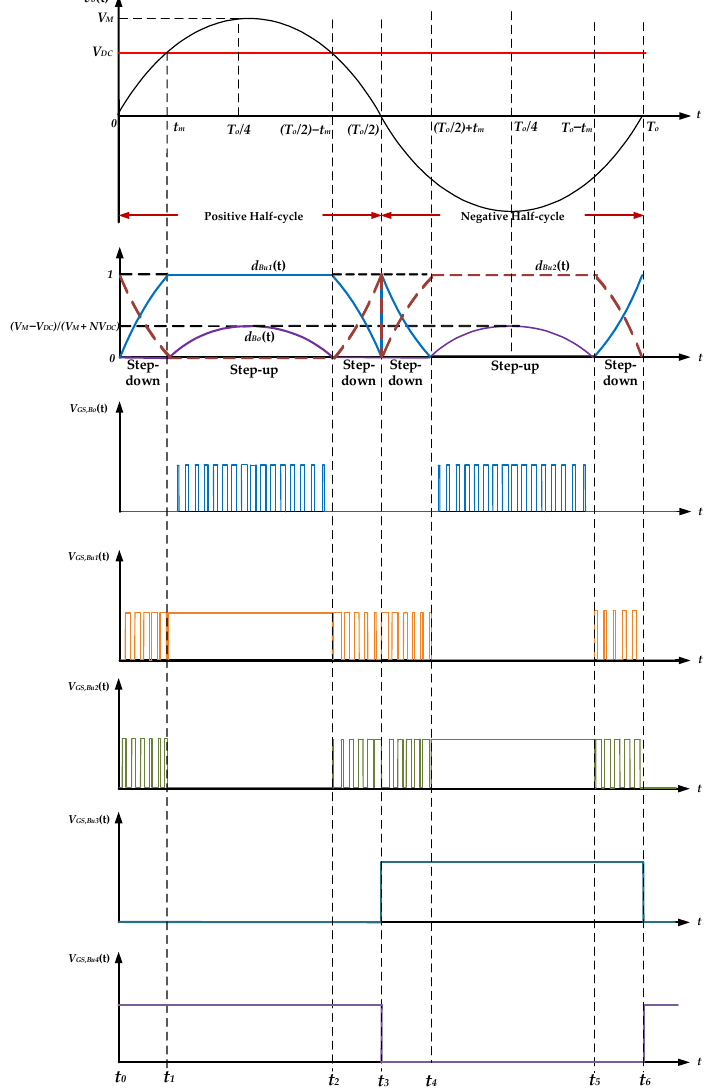
Figure 5. The timing diagram of the proposed high-gain inverter. The output voltage v o ( t ) is sinusoidal and can be divided into positive and negative half-cycles. When the input voltage V DC is higher than the absolute value of the instanta- neous output voltage v o ( t ), the inverter operates in step-down mode; otherwise, the